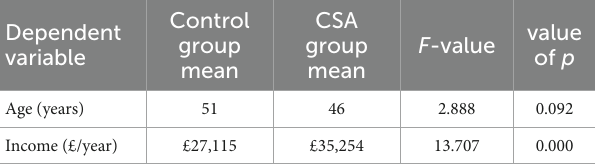
TABLE 1 Results from ANOVA for income [equivalised household disposable income, using the modified Organisation for Economic Co-operation and Development (OECD) scale] and